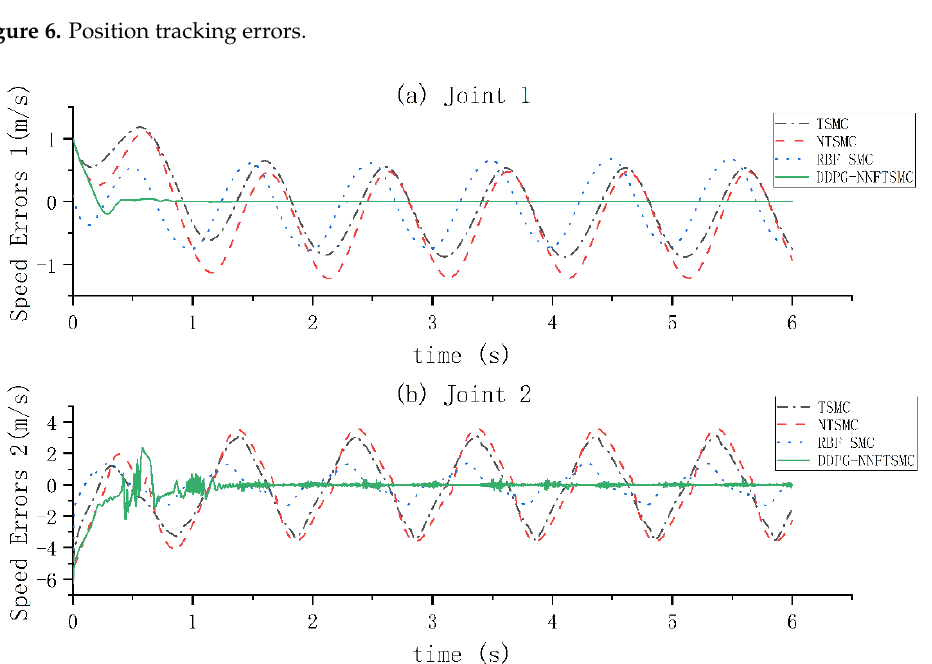
Figure 7. Speed tracking